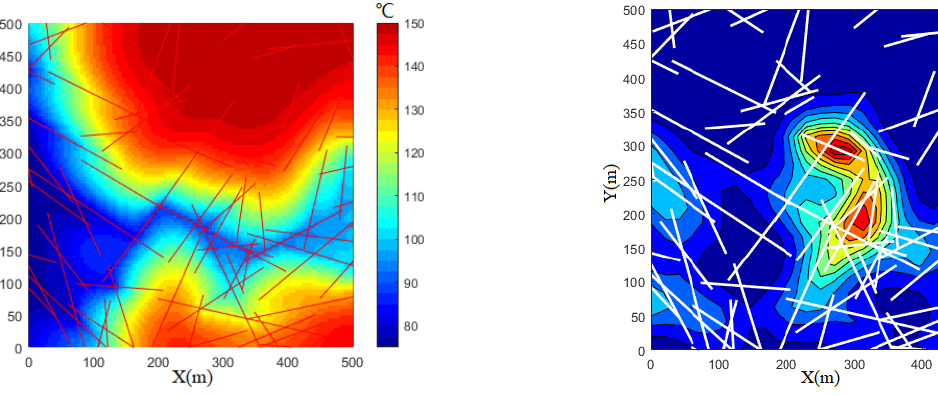
( h ) Connectivity Field Calculated by the Proposed Method Figure 13. Temperature distribution and connectivity field for complex fracture networks. ( a , c , e , g ) is the temperature distribution. ( b , d , f , h ) is the fracture-network connectivity filed. ( a , b ) are for uniform fracture networks with the same fracture conductivity. ( c , d ) are for fracture networks with the same fracture conductivity and 45° orientation from the north. ( e ) and ( g ) have the same fracture networks, however, the fracture conductivity in ( g ) is 10 times than that in ( d ).